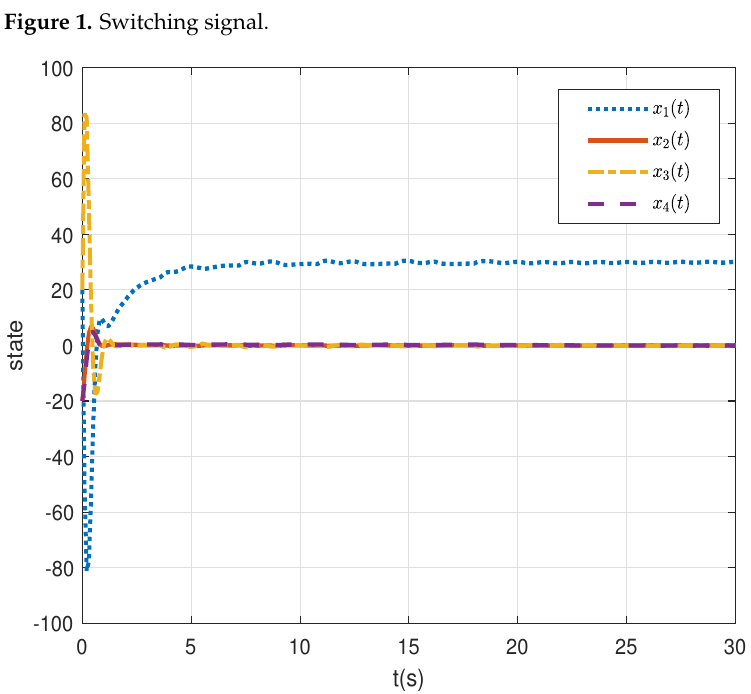
Figure 2. Trajectory of the system